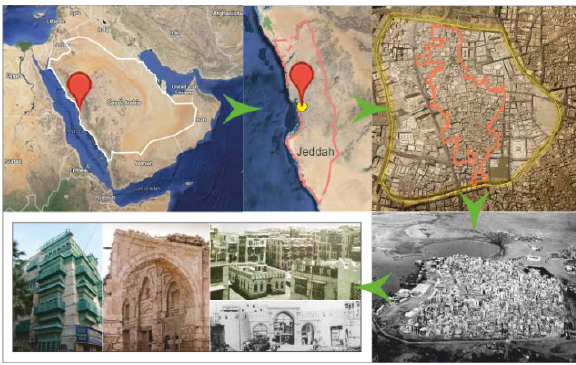
Figure 2. The geographic location of the study area